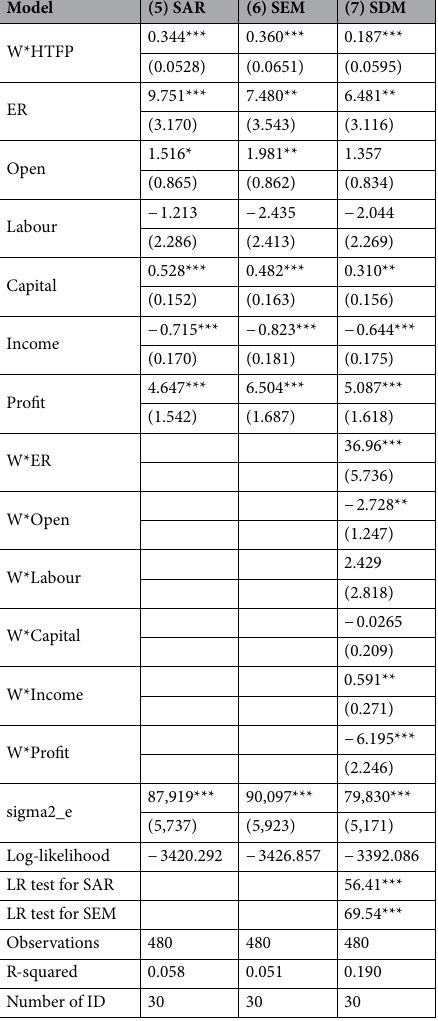
Table 5. Result of spatial econometric model. *, **, ***indicate significance at the 10%, 5% and 1% level, and the standard errors are in